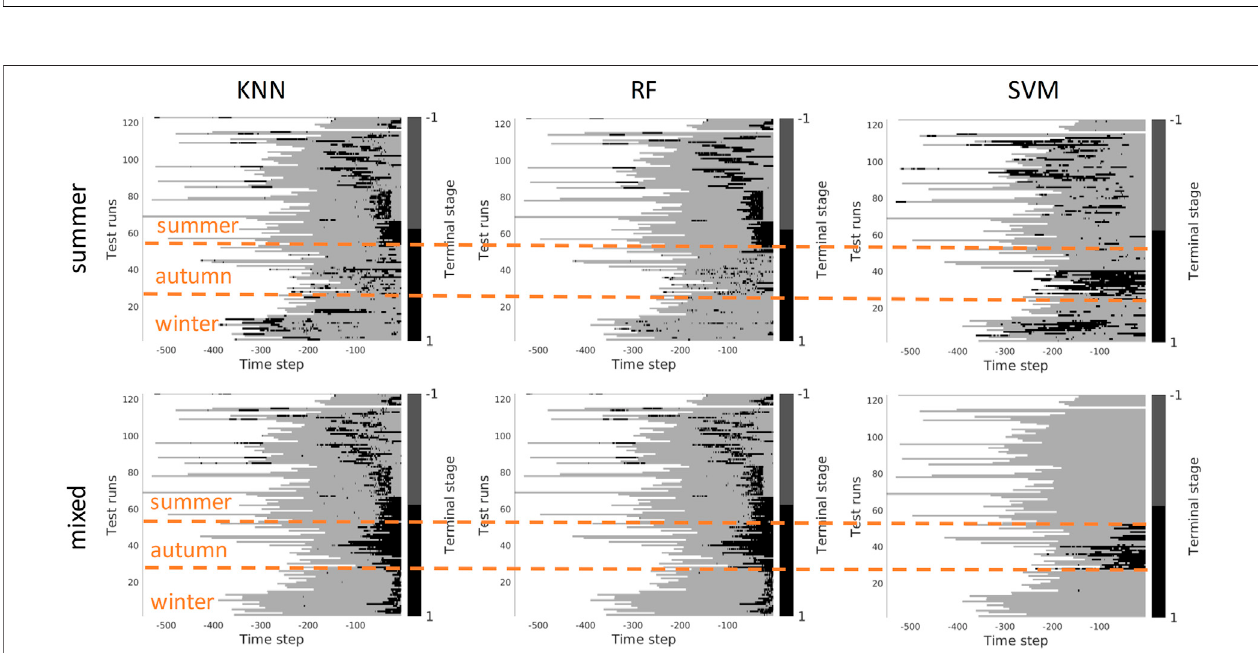
FIGURE13| Identi fi cationoftheterminalstageplottedforallseasons.Upperrow:scenario1-trainedonthesummersetofdata D summer ).Lowerrow:Scenario2- trained on the mixed set of data. x -axis stands for the time step in reversed order to match the samples of varying length. Color bar encodes whether the machine reached terminal stage or not: non-terminal - gray, terminal -